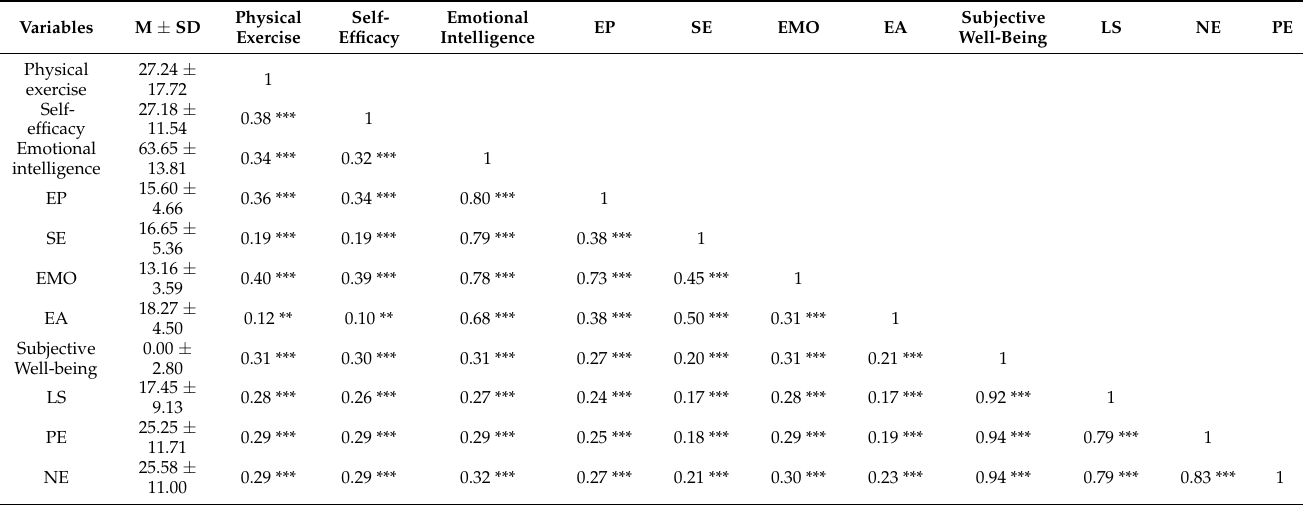
Table 2. Correlation analysis table of the amount of physical exercise, self-efficacy, emotional intelli- gence, and subjective well-being of college students ( n =